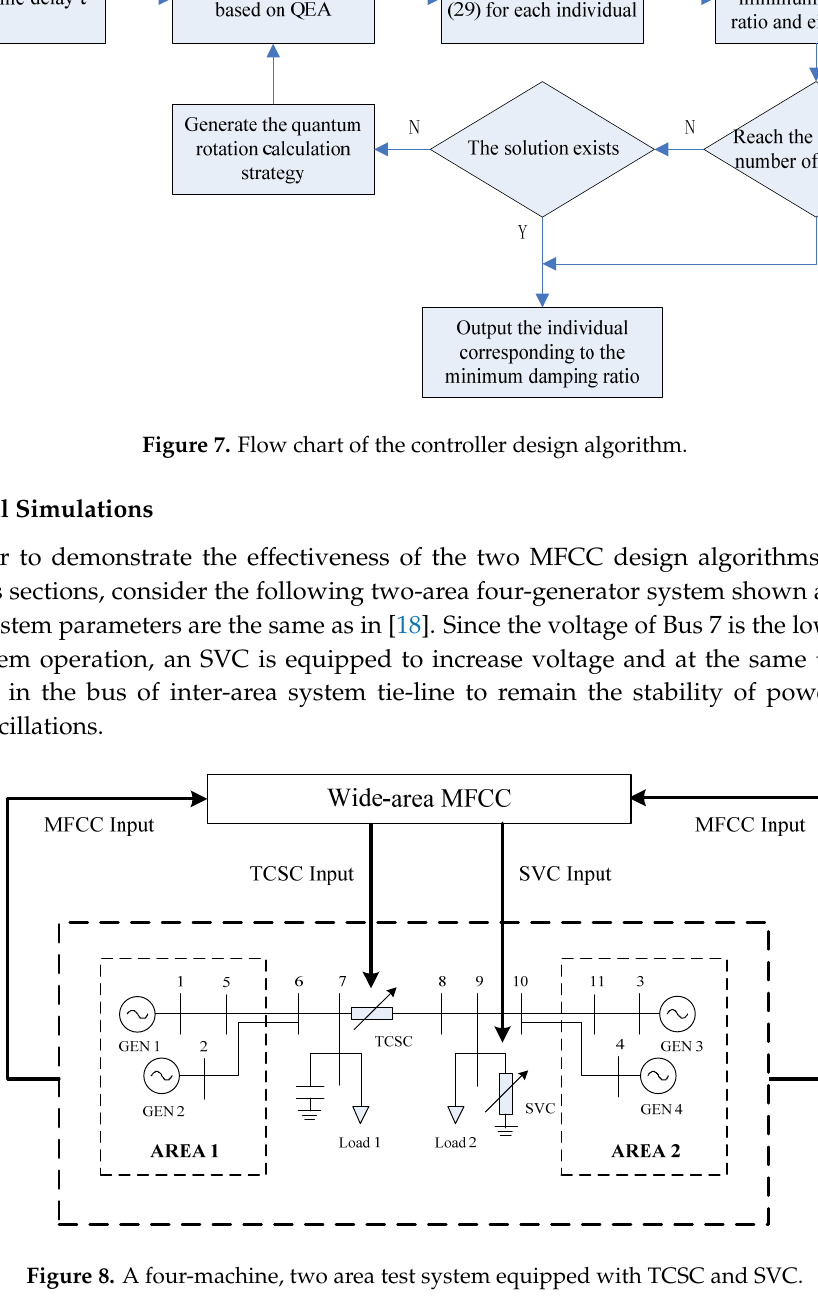
Figure 8. A four ‐ machine, two area test system equipped with TCSC and SVC.